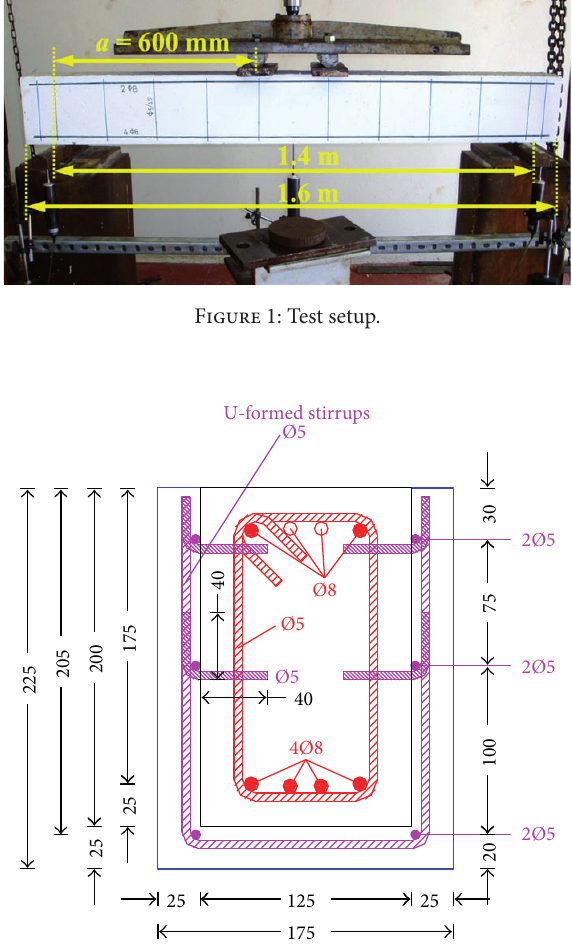
F2:Cross-sectionaldimensionsandsteelreinforcementofthe jacketed